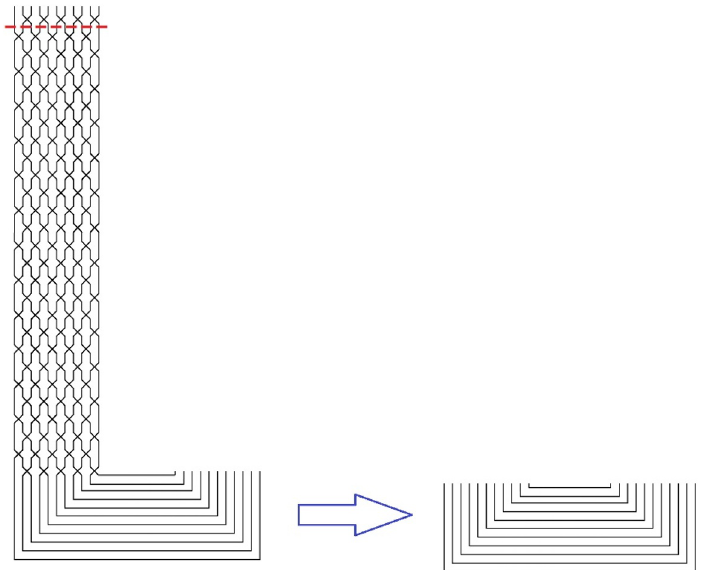
1 TFD back to (cid:10) j i